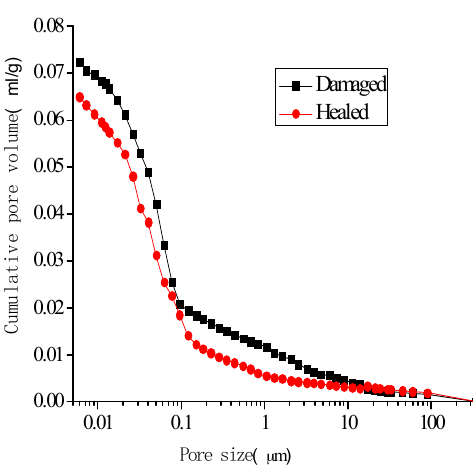
Figure 16. Cumulative-pore volume distribution for specimens with 6% microcapsules.